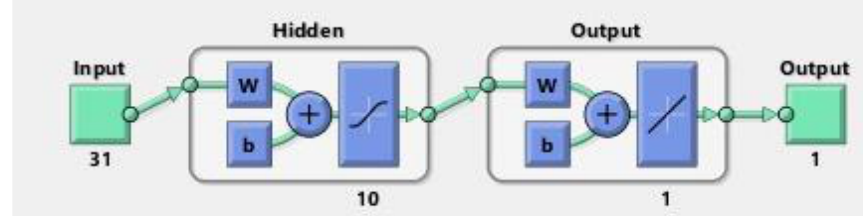
Figure 3. The architecture of the ANN model for each water quality parameter.